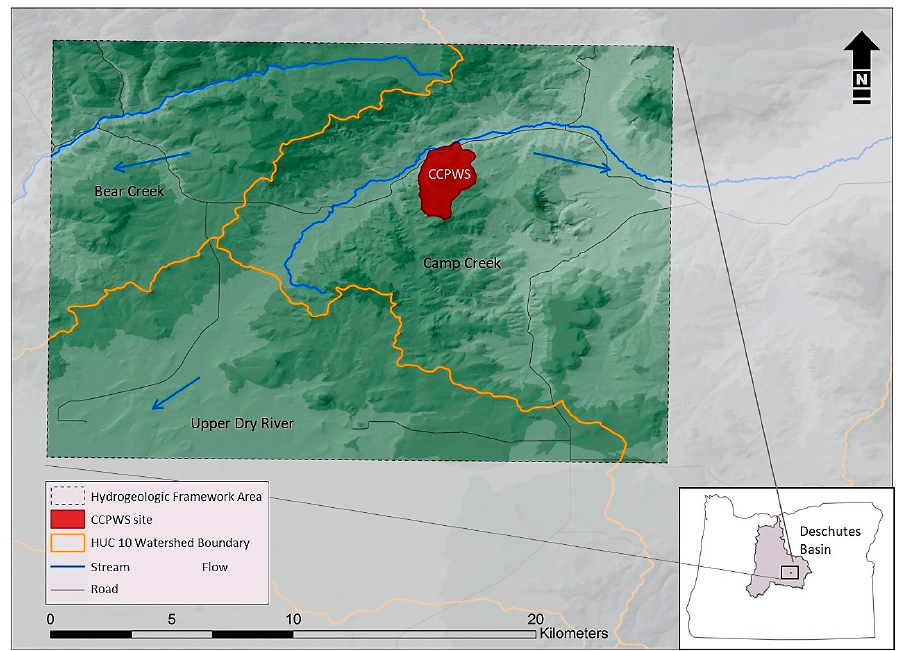
Figure 1. Map of study region in the Deschutes Basin illustrating the larger hydrogeologic framework area and the Camp Creek Paired Watershed Study (CCPWS) site.